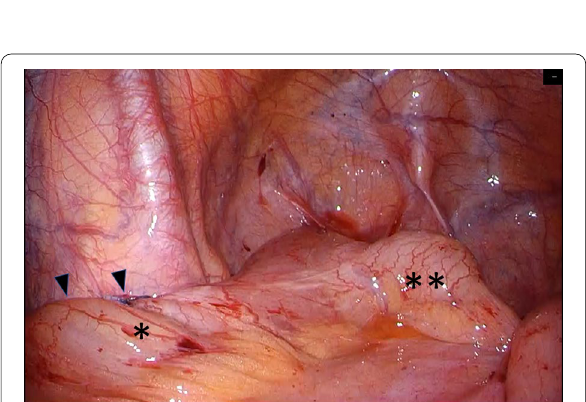
Fig. 7 Laparoscopic afferent limbpexy was performed on the left lateral pelvic wall (black up-pointing triangle). *: Afferent limb, **: efferent limb of the